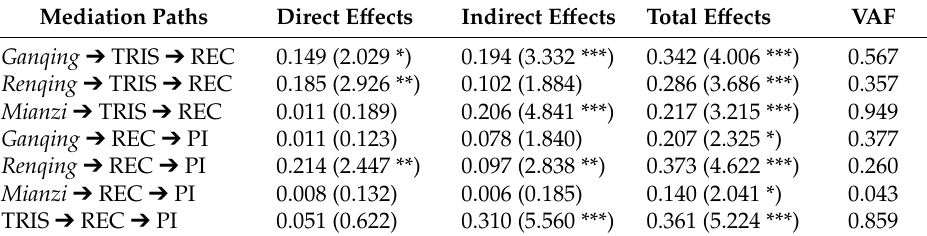
Table 3. Results of test on mediating e ff